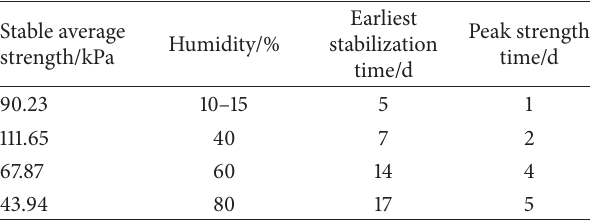
Table 5: Strength, earliest stabilization time, and curing humidity in the stable